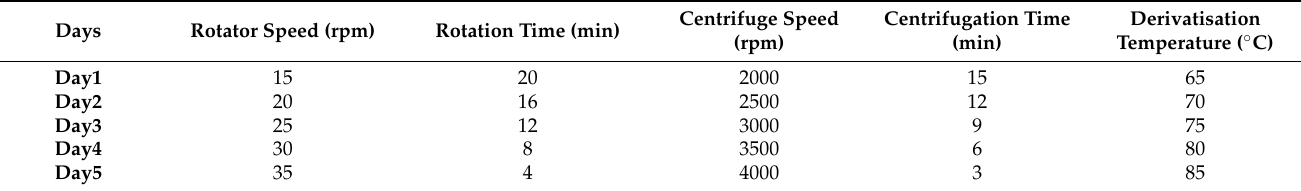
Table 5. Parameters observed for method ruggedness.